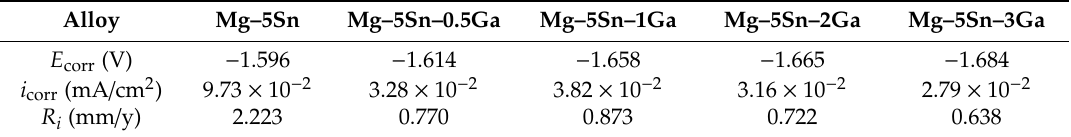
Table 4. Fitting results of polarization curves of the Mg–5Sn– x Ga alloys with varying Ga content in 3.5 wt % NaCl